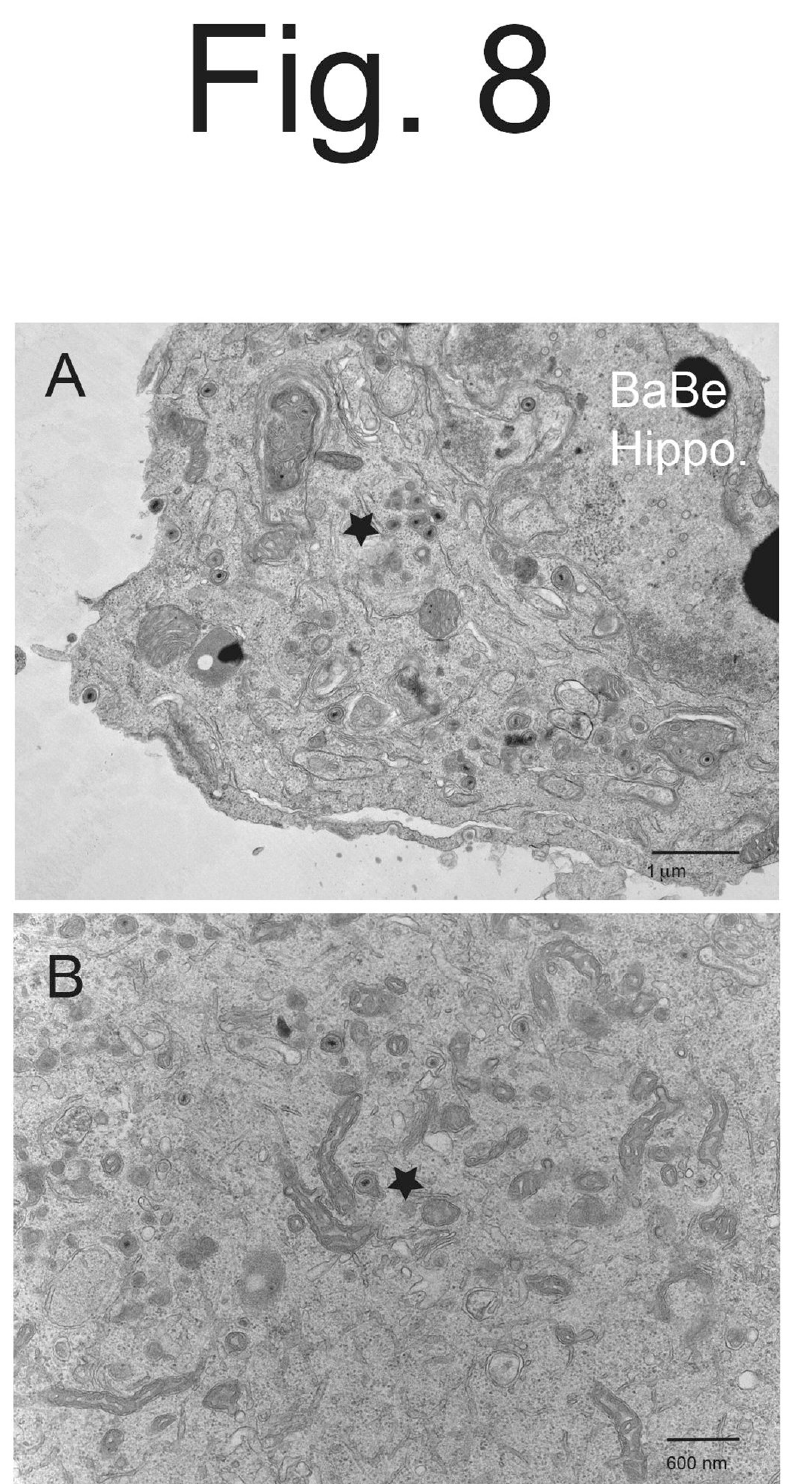
Figure 8. Higher magnification EM of hippocampal neurons infected with PRV BaBe. Hippocam- pal neurons on Thermanox coverslips were infected with PRV BaBe then processed for EM. Panel ( A ) shows numerous cytoplasmic virions that were misassembled, in some cases with numerous virions inside a single vesicle (star). Panel ( B ) shows a cytosolic enveloped virion with electron-dense material extending from one pole of the capsid (star). There were also several partially enveloped capsids in this